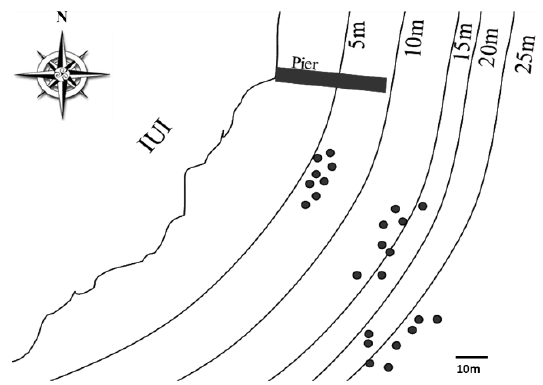
Figure 1. Map of the Acropora loripes sampling sites in front of the Interuniversity Institute for Marine Sciences (IUI), stating coral colony locations and depths.